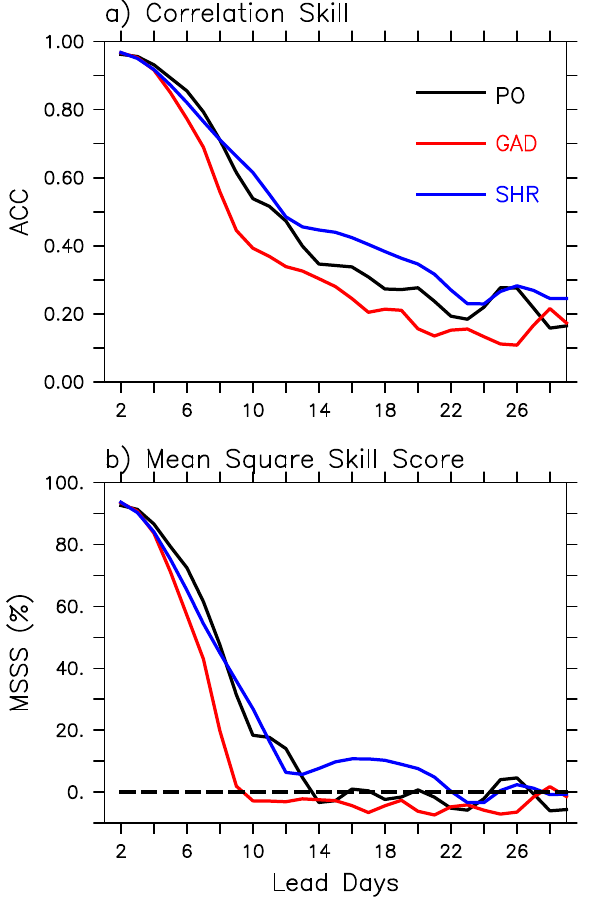
Fig. 5 Prediction of the PCs of leading three subseasonal circulation modes in the GFDL SPEAR model. a The anomalous correlation skill of PCs for these three modes as a function of the lead time. b is similar to a but for the mean square skill score (MSSS) of PCs for these three modes.